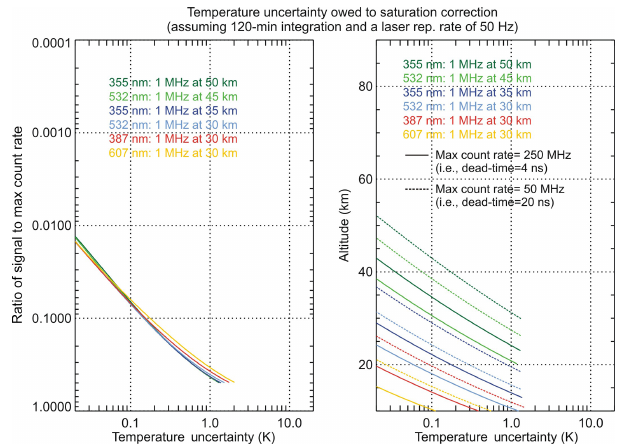
Figure 1. Temperature uncertainty owing to detection noise as a function of lidar signal magnitude (left) and altitude (right) for a variety of lidar performance configurations, specifically, two differ- ent signal strengths (1MHz in the upper stratosphere and 1MHz in the lower stratosphere), two different emission wavelengths (ul- traviolet and green), three different vertical samplings (15, 75, and 300m), and two types of backscatter (Rayleigh and Raman). The solid circles indicate the location of the 1MHz signal count rate for a specific channel.